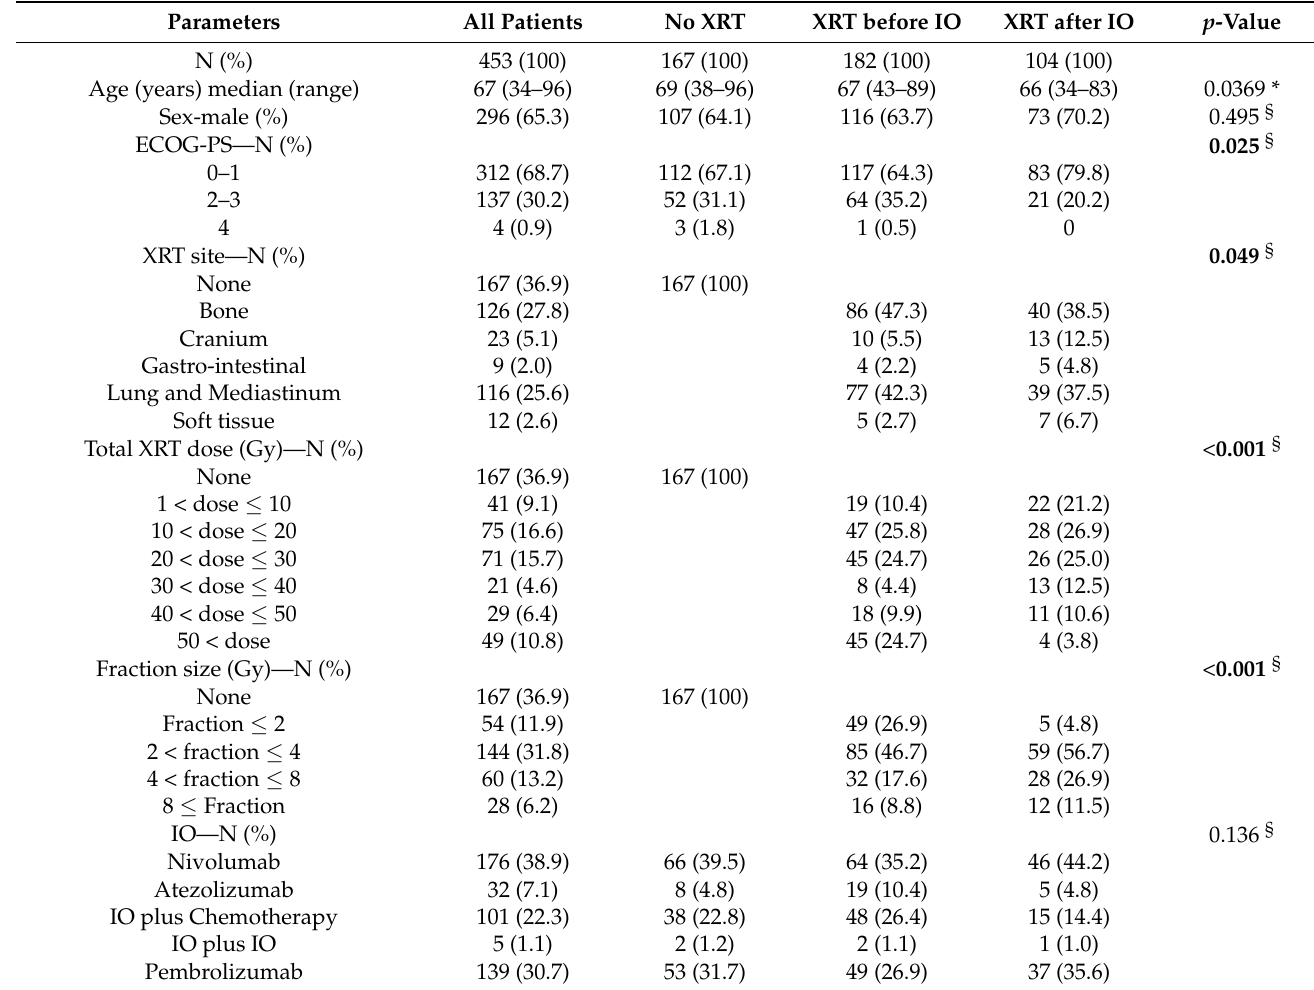
Table 1. Characteristics of the patients included in the